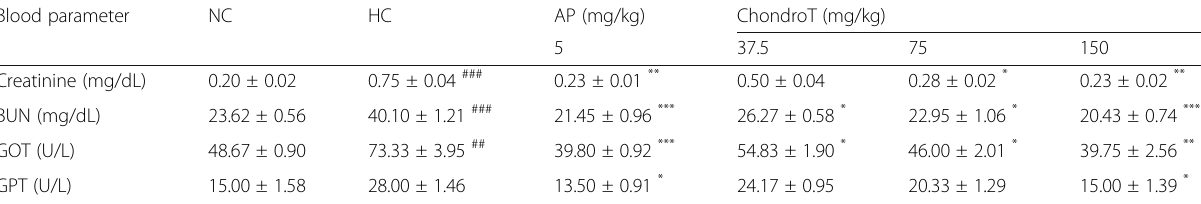
Table 4 Effects of ChondroT on serum levels of Creatinine (Cr), blood urea nitrogen (BUN), glutamic oxaloacetic transaminase (GOT) and glutamic pyruvic transaminase (GPT) in hyperuricemic mice Blood